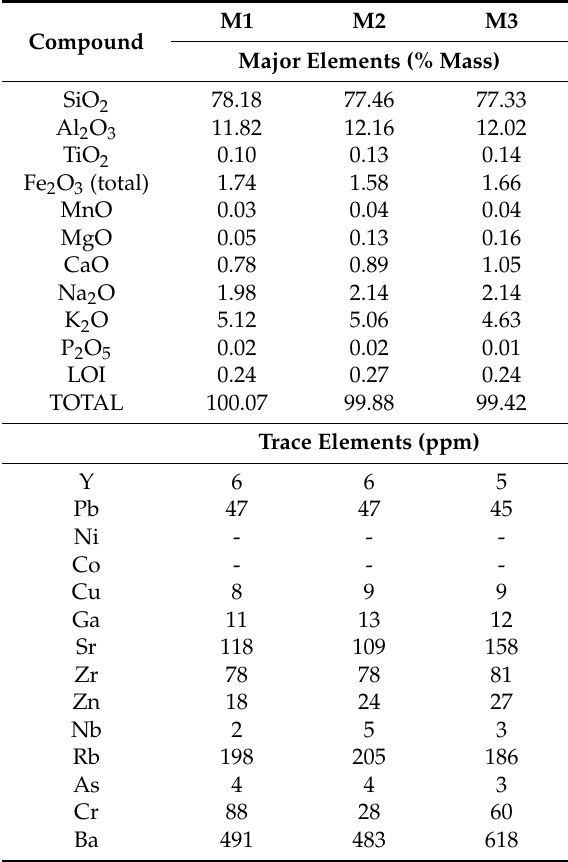
Table 1. Chemical composition of